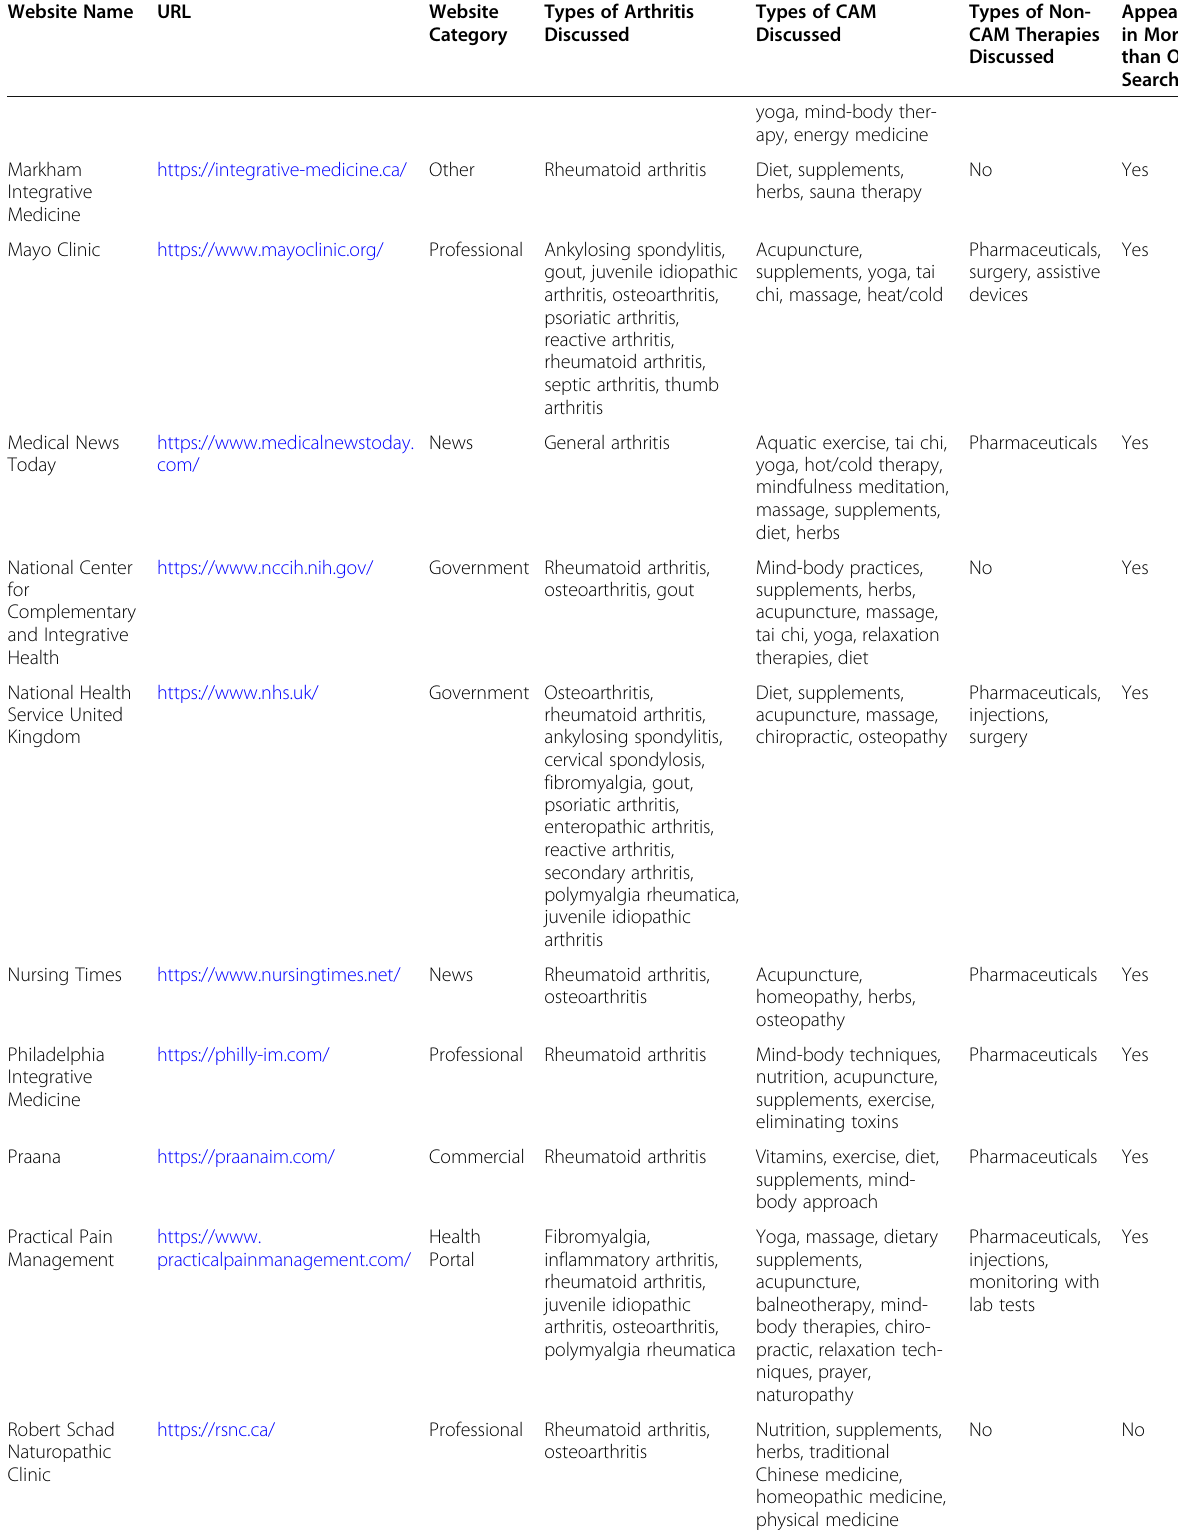
Table 1 General Characteristics of Eligible Websites